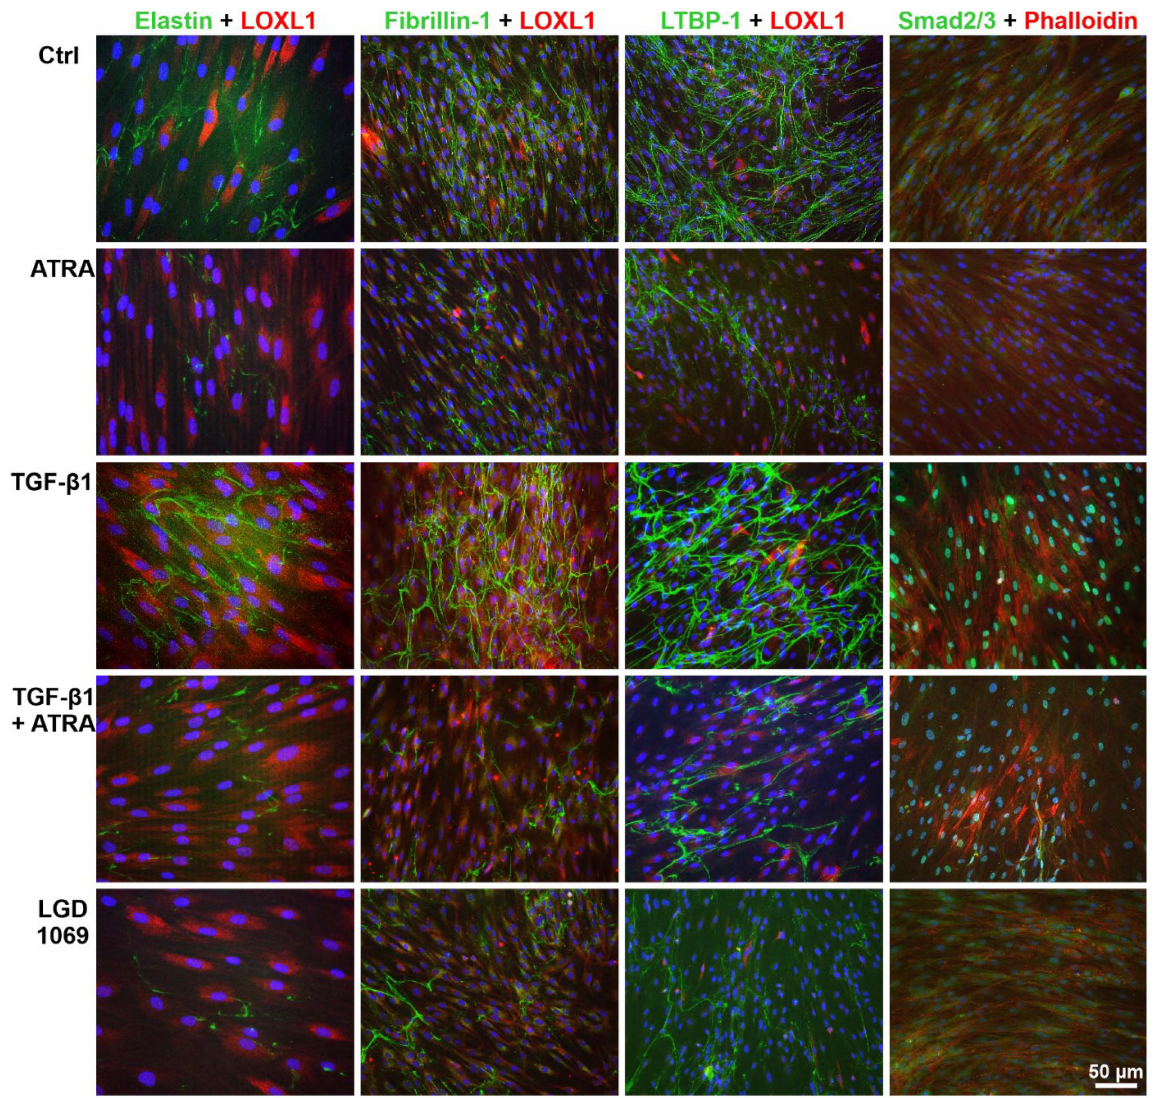
Figure 10. Immunofluorescence analysis of microfibrillar network composition in response to retinoic acid pathway activation. Immunofluorescent double labeling for elastin, fibrillin-1, LTBP-1, or Smad2/3 (green fluorescence) and LOXL1 or Alexa Fluor 555-conjugated phalloidin (red fluores- cence) in cultures of human Tenon’s capsule fibroblasts treated with 2 µ M all-trans retinoic acid (ATRA), 5 ng/mL transforming growth factor- β 1 (TGF- β 1), 5 ng/mL TGF- β 1 plus 2 µ M ATRA, or 10 µ M of LGD 1069 (pan-RXR agonist) for 7 days; untreated cells served as control (Ctrl); nuclear counterstaining with 4 (cid:48) ,6-diamidino-2-phenylindole (DAPI, blue